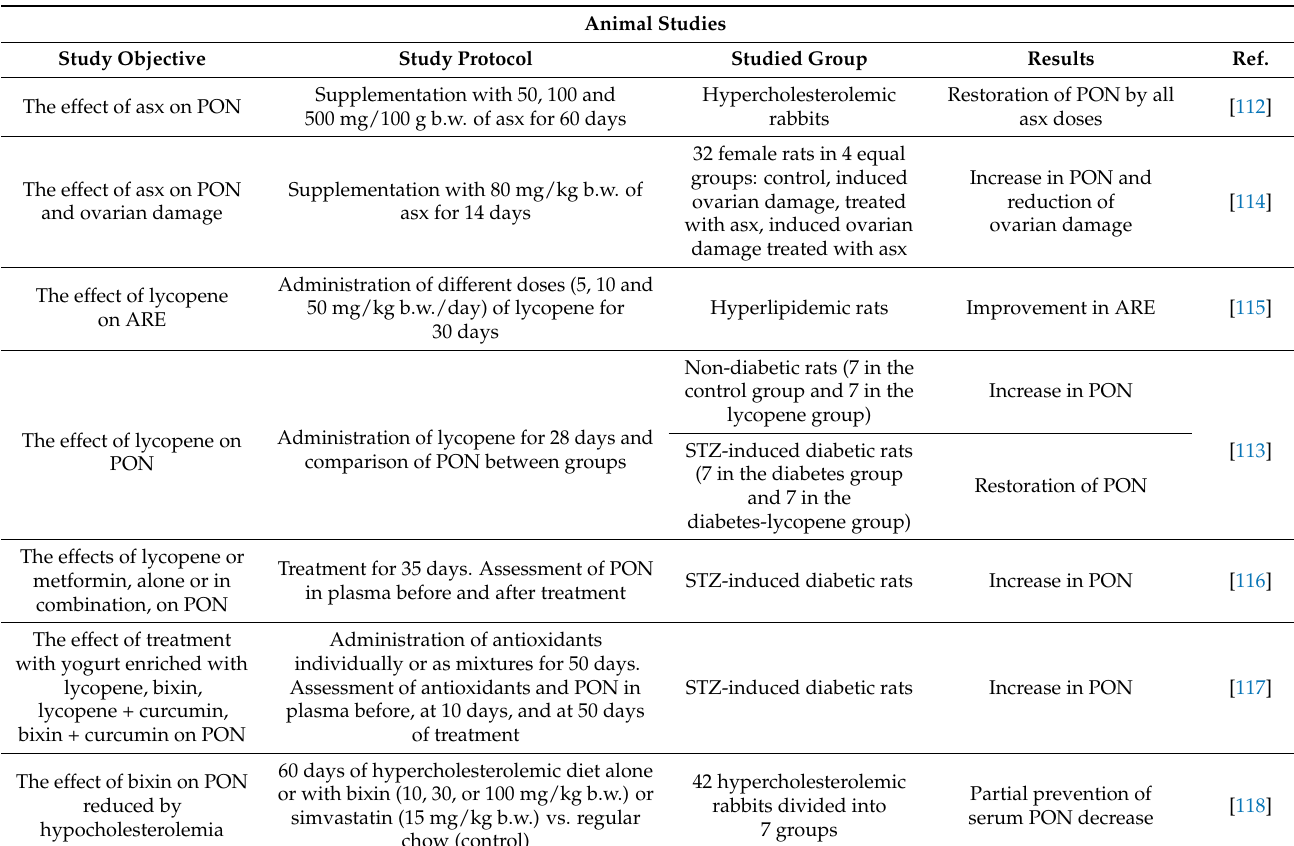
Table 3. Overview of animal studies on the effect of carotenoids on PON1 gene expression and PON1 (paraoxonase 1)